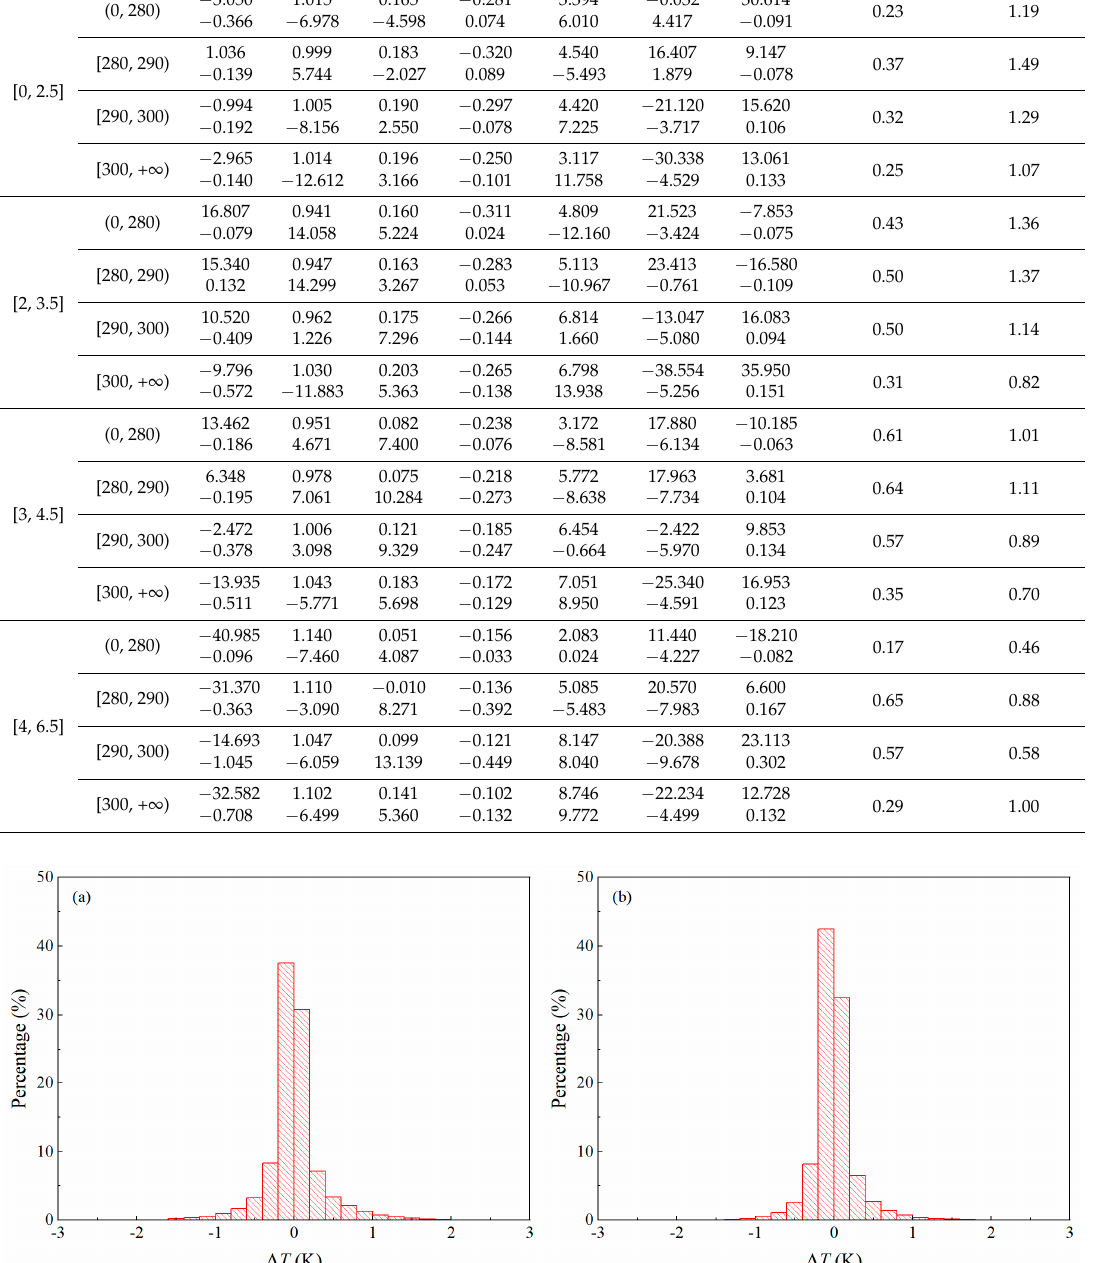
Table 2. Coefficients and RMSEs of different subranges for the nighttime algorithm where VZA = 0 ◦ . CWV (g/cm 2 ) With Noise